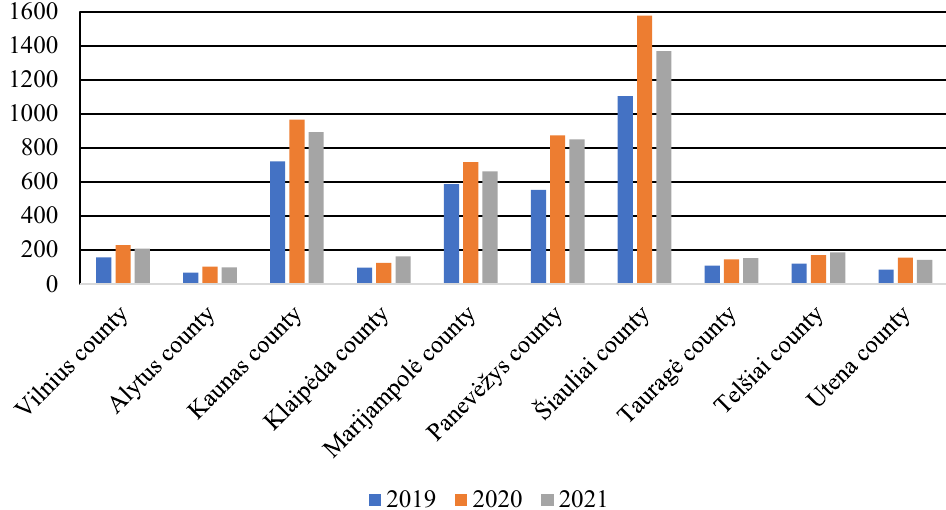
Figure 7. The potential of biodiesel production from oil crop waste (bran) in the counties (t).